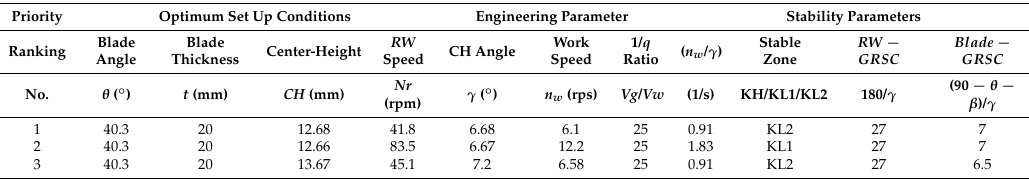
Table 4. Examples of outputs from Opt-Setup